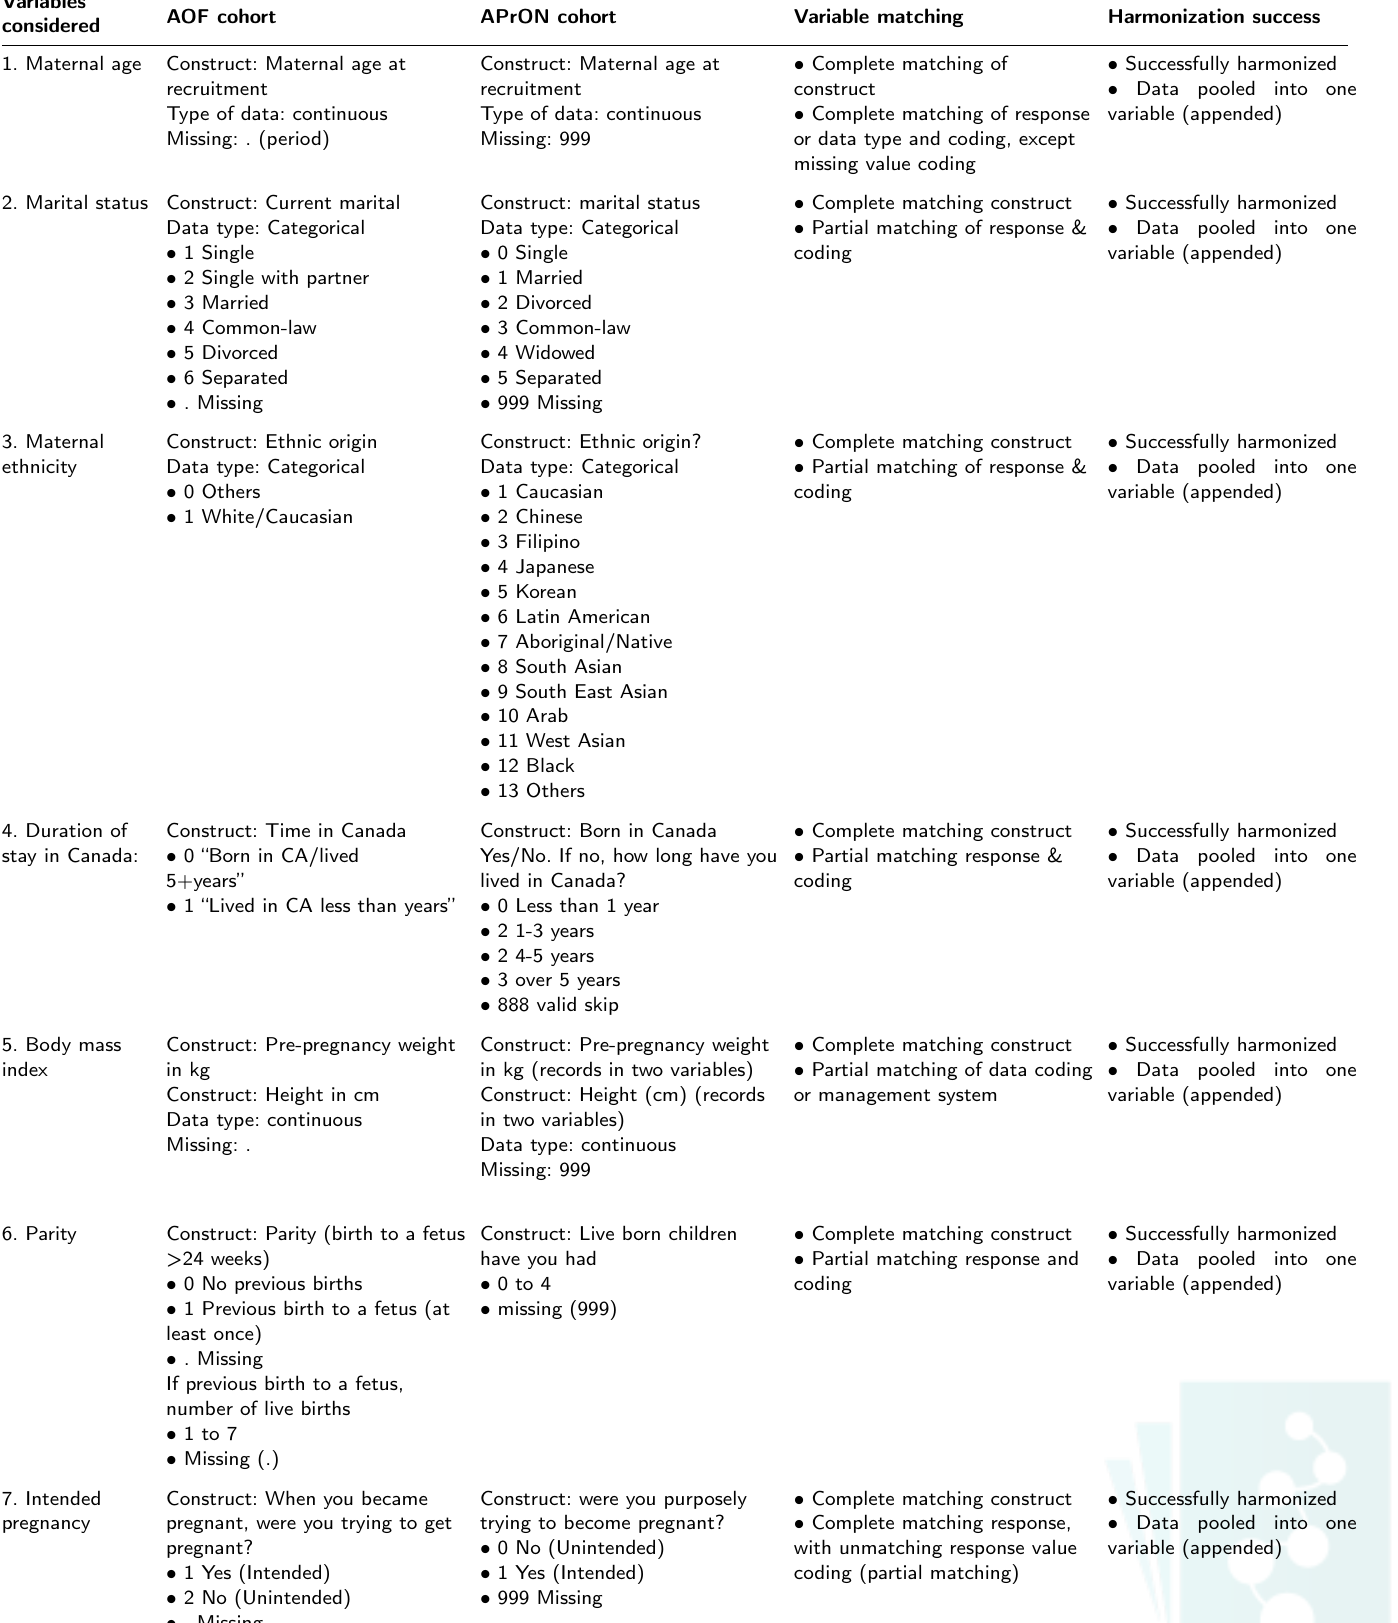
Supplementary Table 2: List of AOF and APrON variables related to our research and selected for harmonization Variables